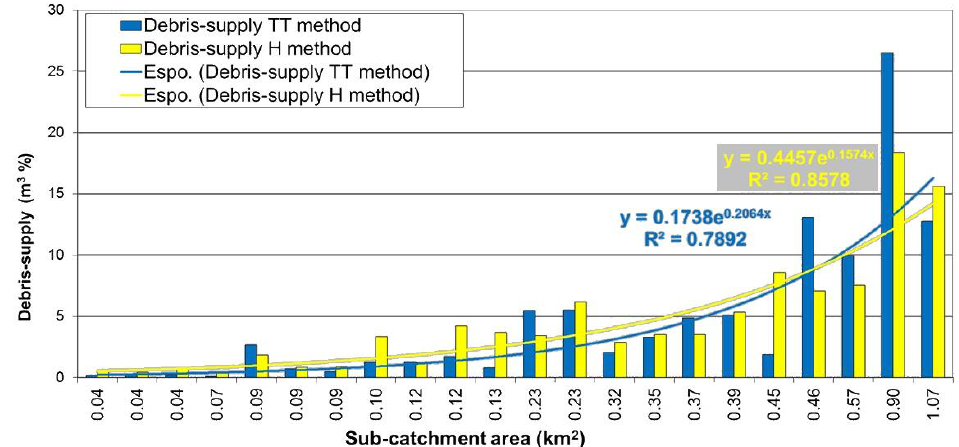
Figure 18. Minimum values of the debris-supply volumes calculated with TT and H formulae for each sub-basin; this graph appears rather meaningful when checking the soundness of the analytical comparison between the two methods. Exponential curves are in link with the basin areas.